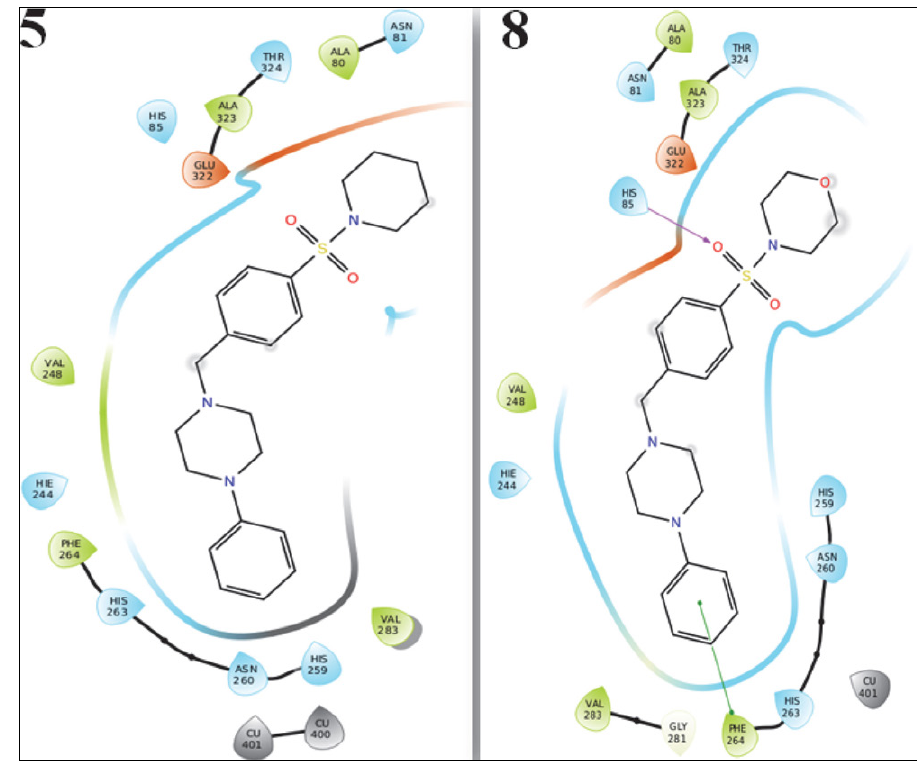
Figure 8. 2D binding interactions of 5 and 8 against tyrosinase protein.